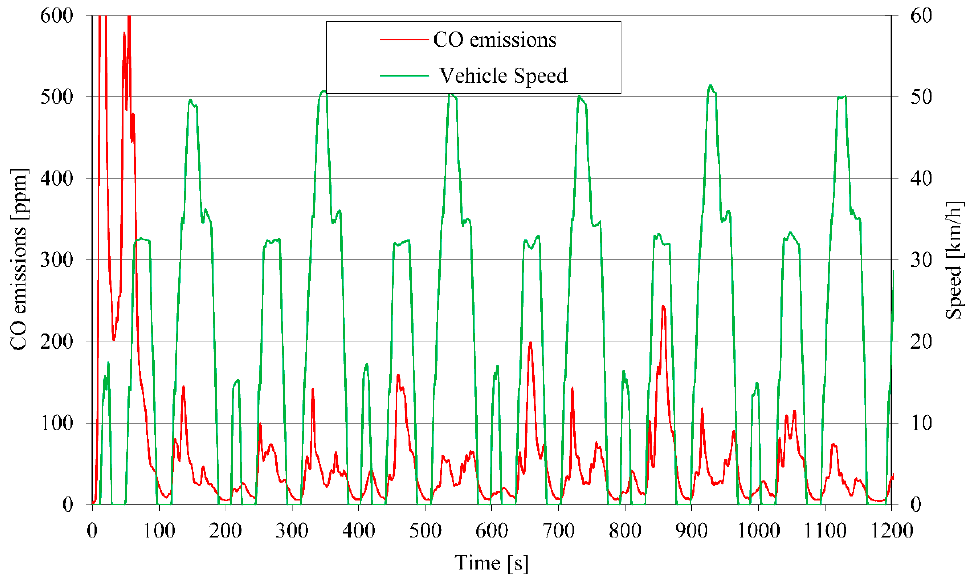
Figure 2. CO instantaneous emissions and speed–time profile measured during the UDC driving cycle.